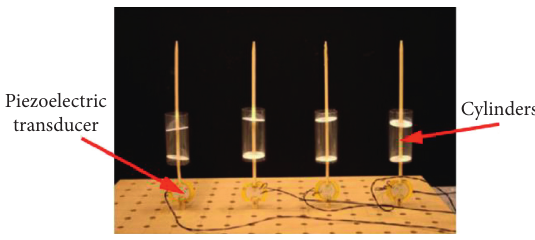
Figure 12: Photograph of four piezoelectric devices in tandem